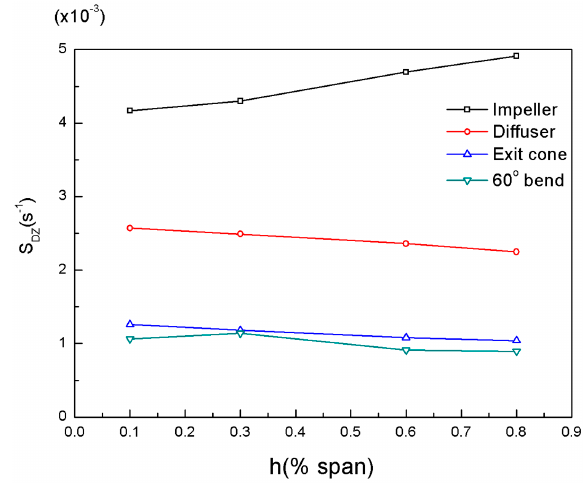
Figure 11. The 𝑆 (cid:3005)(cid:3027) (reflecting the overall turbulent entropy generation rate for a domain) of different Figure 11. The S DZ (reflecting the overall turbulent entropy generation rate for a domain) of di ff erent domains with varying tip clearance at φ = 0.354 domains with varying tip clearance at ϕ =